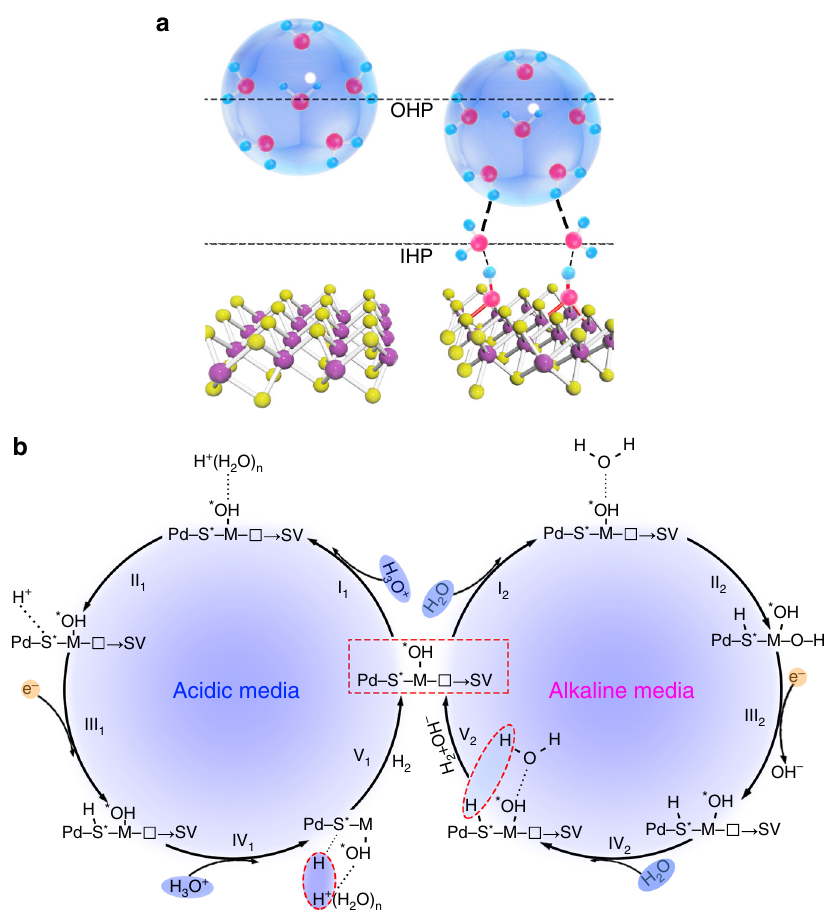
Fig. 4 Correlation of the HER mechanism with the different reaction condition. a Schematic illustration of OH functionality in promoting HER on the di- anionic MoS 2 − x (OH) y electrode through forming strong non-covalent hydrogen bonding to the reactants (hydronium ions or water). b Left: HER mechanism of Pd, Ru – MoS 2 − x OH y in acidic media; Right: HER mechanism of Pd, Ru – MoS 2 − x OH y in alkaline